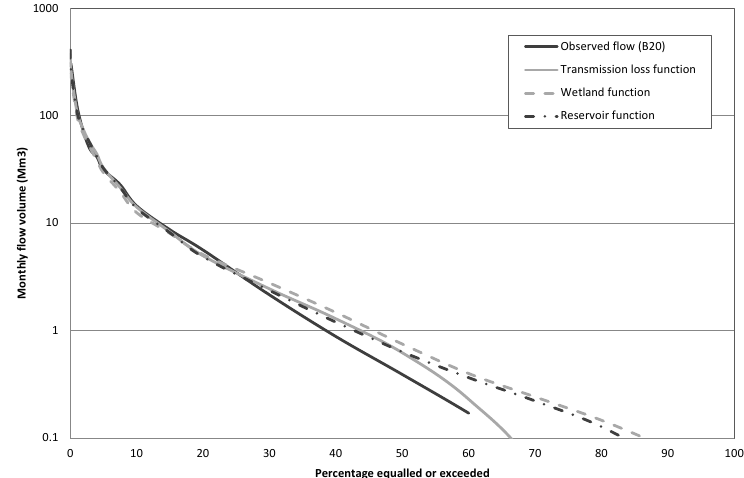
Figure 3. Comparison of observed and simulated flow (Mm 3 ) for the Mzingwane